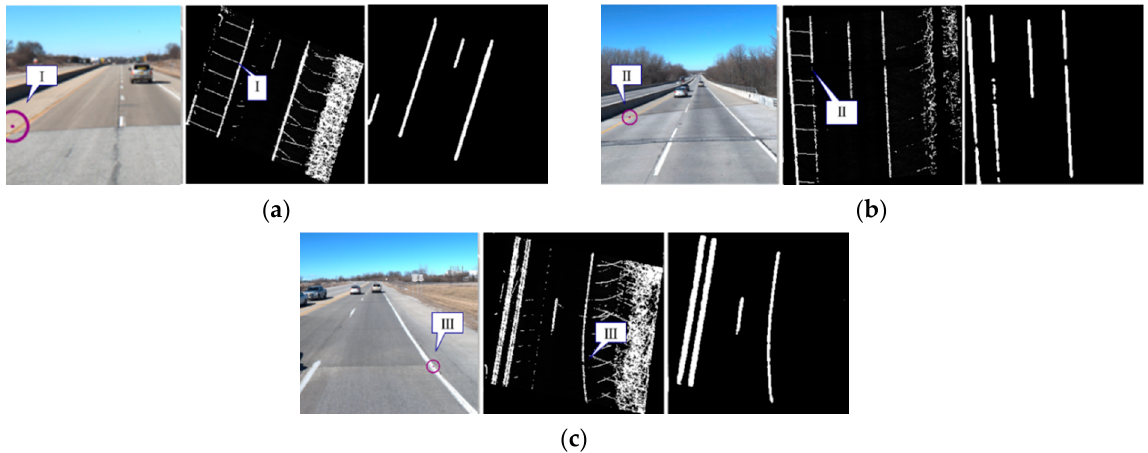
Figure 24. Changes in intensity profiles at locations ( a ) I (asphalt-to-concrete), ( b ) II (concrete-to-asphalt), and ( c ) III (different asphalt pavements) in Figure 23 with RGB image (left), corresponding intensity image (center), and lane marking prediction image (right).